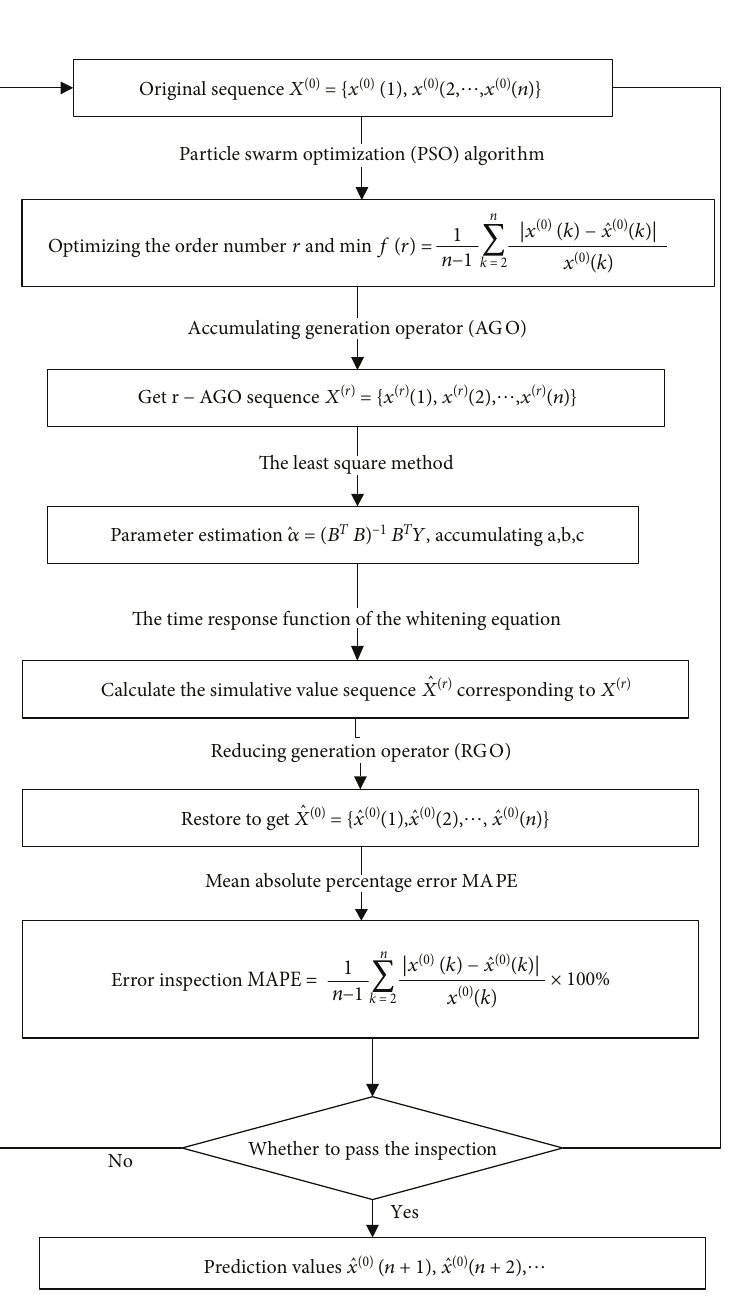
Figure 1: The fl owchart of the FSIGM